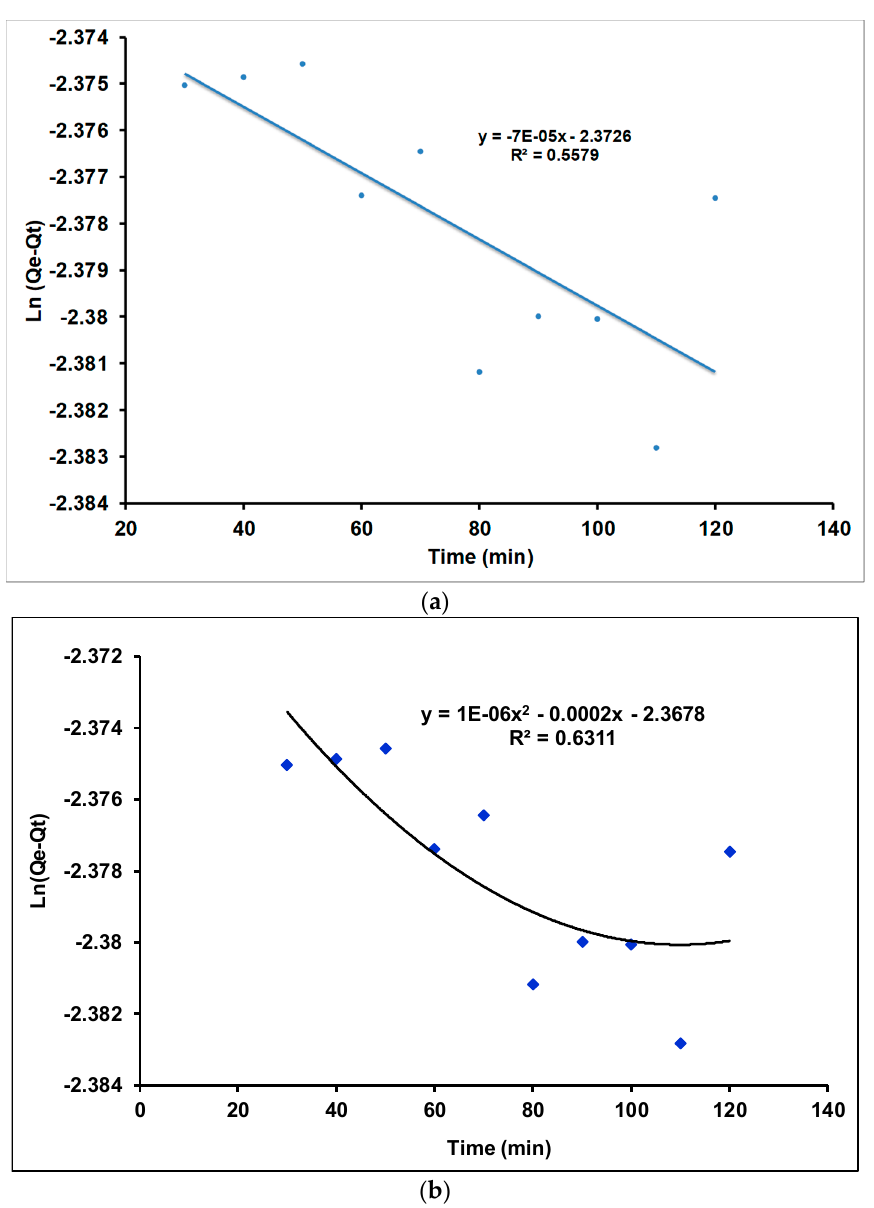
Figure 9. Pseudo-first-order model of Tl(I) adsorption on the γ ANPs: ( a ) linear model and ( b ) quadratic model.